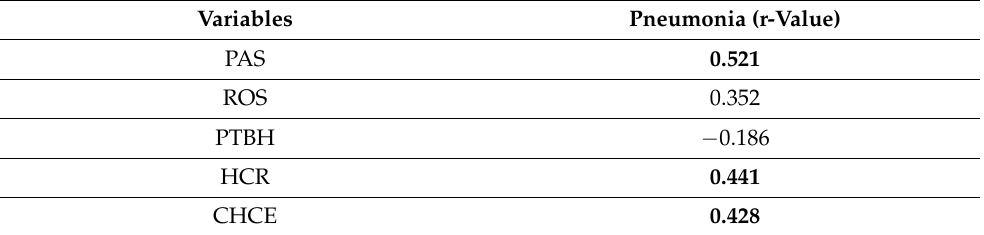
Table 3. Results of the correlation analysis between PAS, ROS, PTBH, HCR, CHCE, and pneumonia.